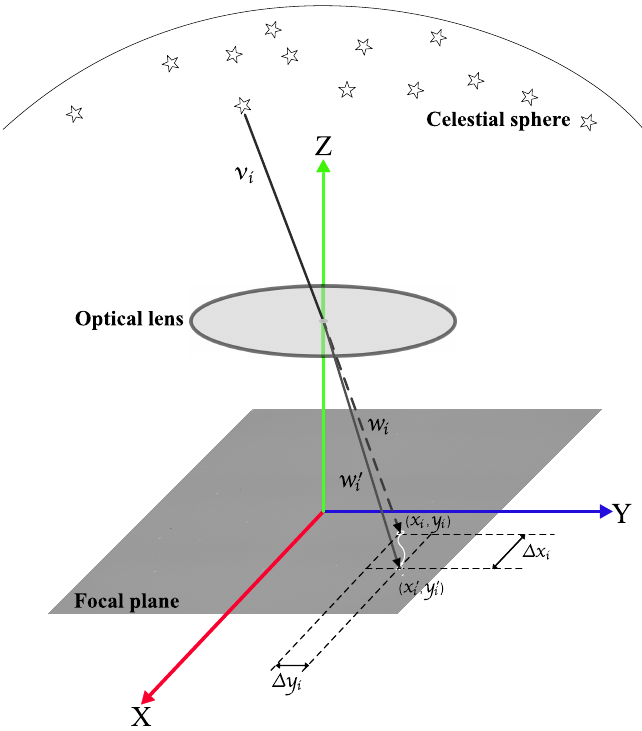
Figure 1. Pinhole imaging system and real star tracker measurement model. Under the ideal condition, the centroid of stars is ( x i , y i ) in the pinhole imaging system. Due to noise and distortion, there are inevitable errors in the real star tracker measurement model. The real centroid is ( x (cid:48) The real imaging system is based on the pinhole imaging system.